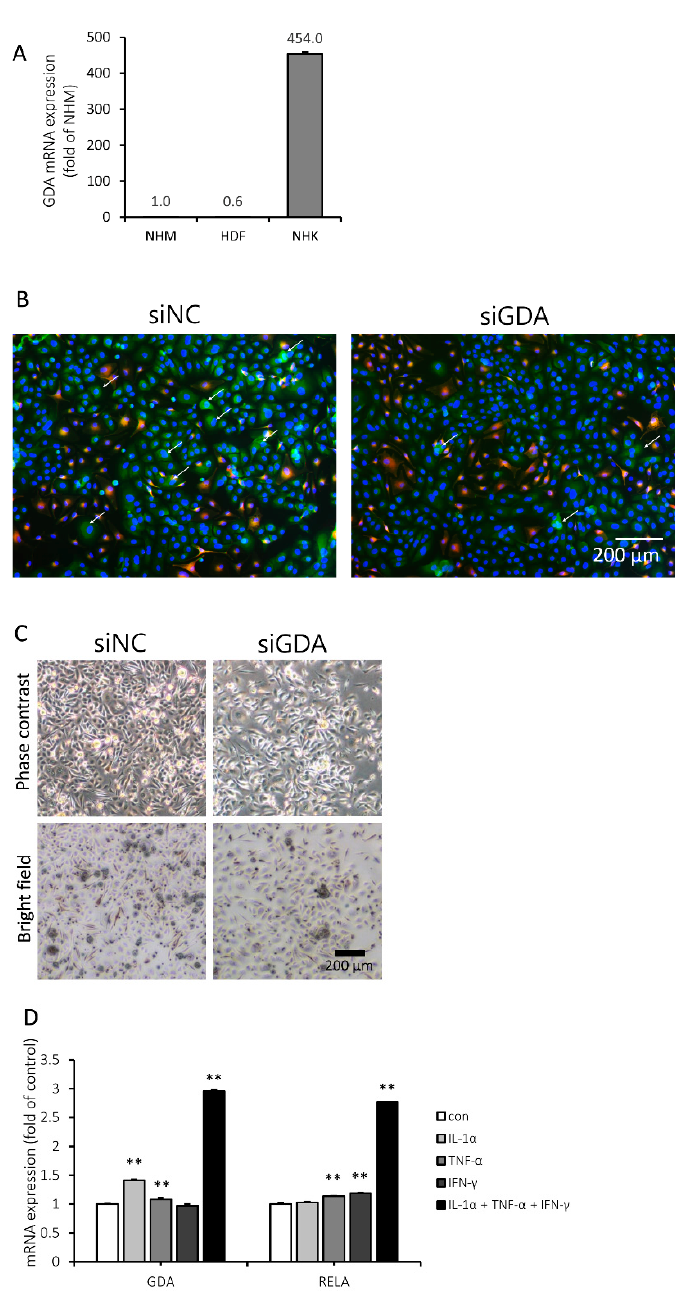
Figure 2. Guanine deaminase (GDA) was mainly expressed in human keratinocytes (KCs) and upregulated when treated with a mixture of inflammatory cytokines. ( A ) The relative GDA mRNA expression levels in normal human melanocytes (NHMs), human dermal fibroblasts (HDFs), and normal human keratinocytes (NHKs) were calculated after normalization to the RPLP0 gene. ( B ) NHMs cocultured with NHKs were transfected with negative control siRNA (siNC) or GDA (siGDA) for 3 d. To determine whether GDA expression level was decreased and to identify the GDA-expressing cells, the cells were double-stained with GDA (green) and Melan-A (red) and counterstained with 4 (cid:48) ,6-diamidino-2-phenylindole (DAPI) (blue). ( C ) Pigmentary changes in cocultured cells by siGDA were demonstrated in bright-field and phase contrast images. ( D ) NHKs were stimulated with 4 ng / mL interferon gamma (IFN- γ ), 20 ng / mL tumor necrosis factor alpha (TNF- α ), and 20 ng / mL interleukin 1 alpha (IL-1 α ) for 24 h, and the GDA and RELA mRNA expression levels were the highest when treated with a mixture of the three cytokines. ** p < 0.01.